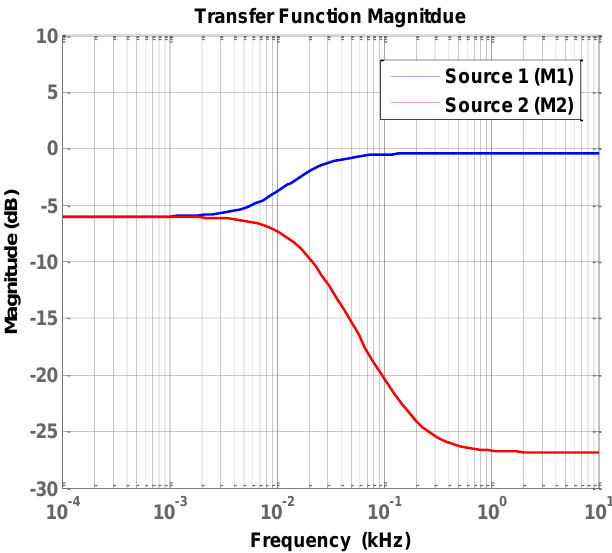
Figure 8. Frequency response of transfer functions for source 1 and source 2.